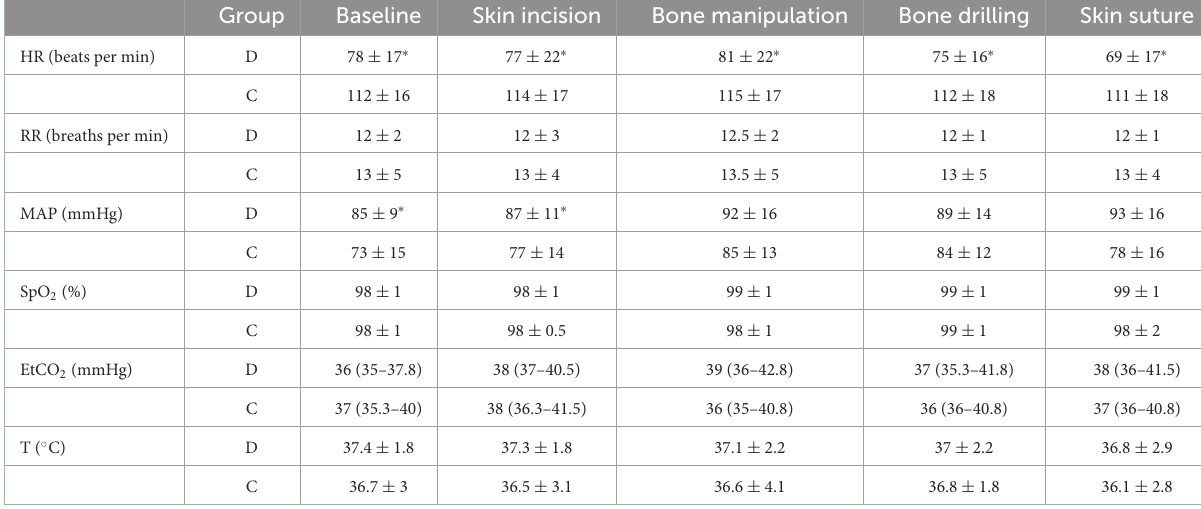
TABLE 2 Physiological variables recorded at predetermined times during surgery.